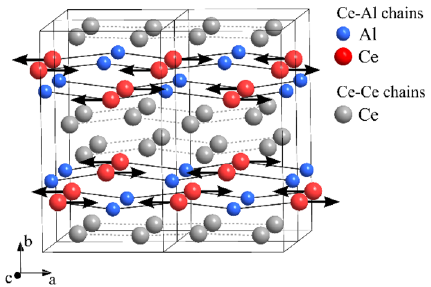
Figure 1. Low-temperature γ -Ce 3 Al crystal structure (adapted from ref. 2 ) with the magnetic structure in zero magnetic field below 2.6 K proposed by neutron scattering 5 . A collinear antiferromagnetic ordering of Ce moments on the Ce–Al chains propagating along the a crystallographic direction is indicated by black